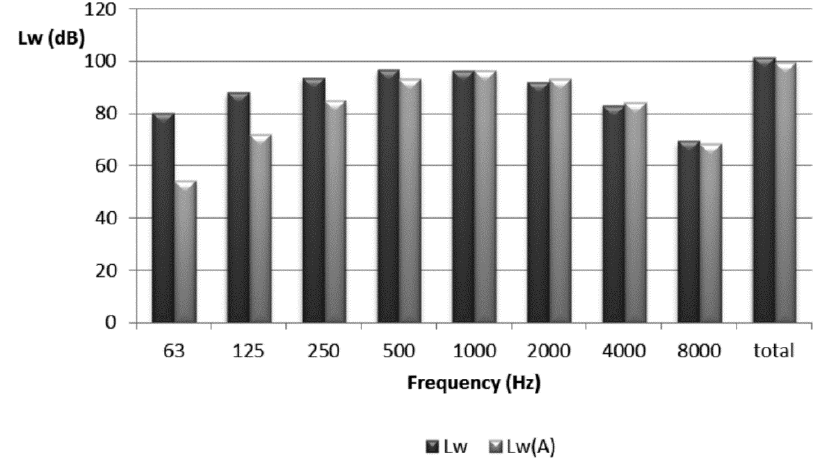
Figure 3. Total and A-weighted sound power levels for a G90 wind turbine.